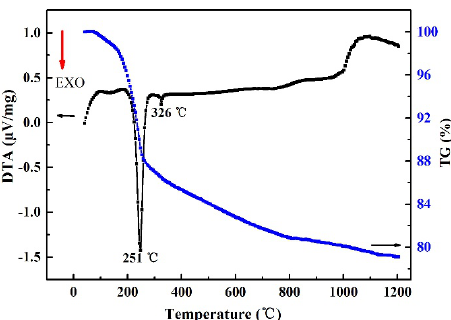
Fig. 3 XRD patterns of A2 ceramic at different